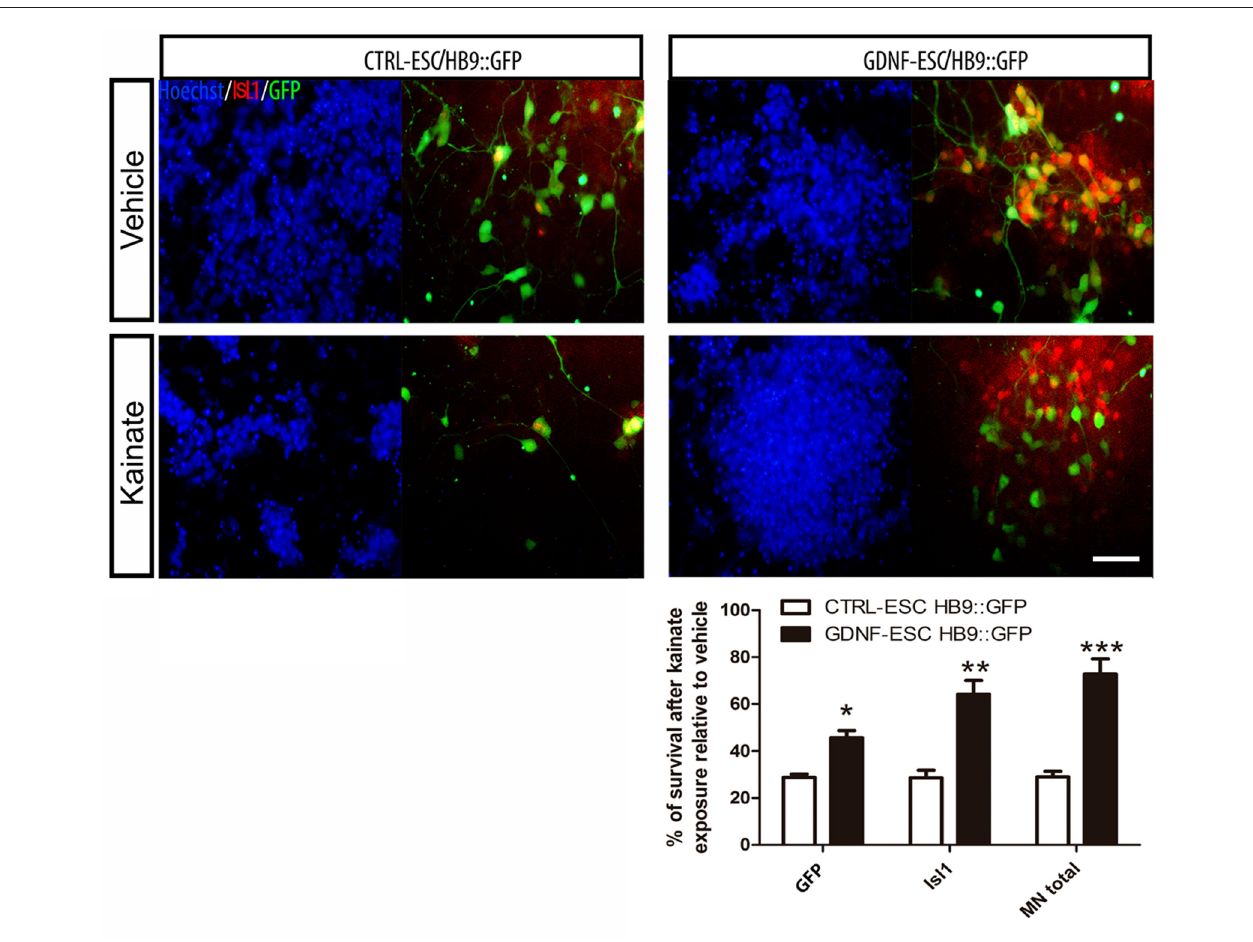
FIGURE 8 | ESC-derived MNs exposed to kainate are protected when GDNF is overexpressed. Differentiated cultures were exposed to vehicle or kainate and assessed survival. The quantification of GFP+, Isl1+ or total MNs (i.e., GFP+ or Isl1+) is presented in the plot. Average ± SEM from three independent experiments performed by duplicate. Scale bar: 50 µ m. ∗ p < 0.05, ∗∗ p < 0.001 and ∗∗∗ p < 0.0001 vs.